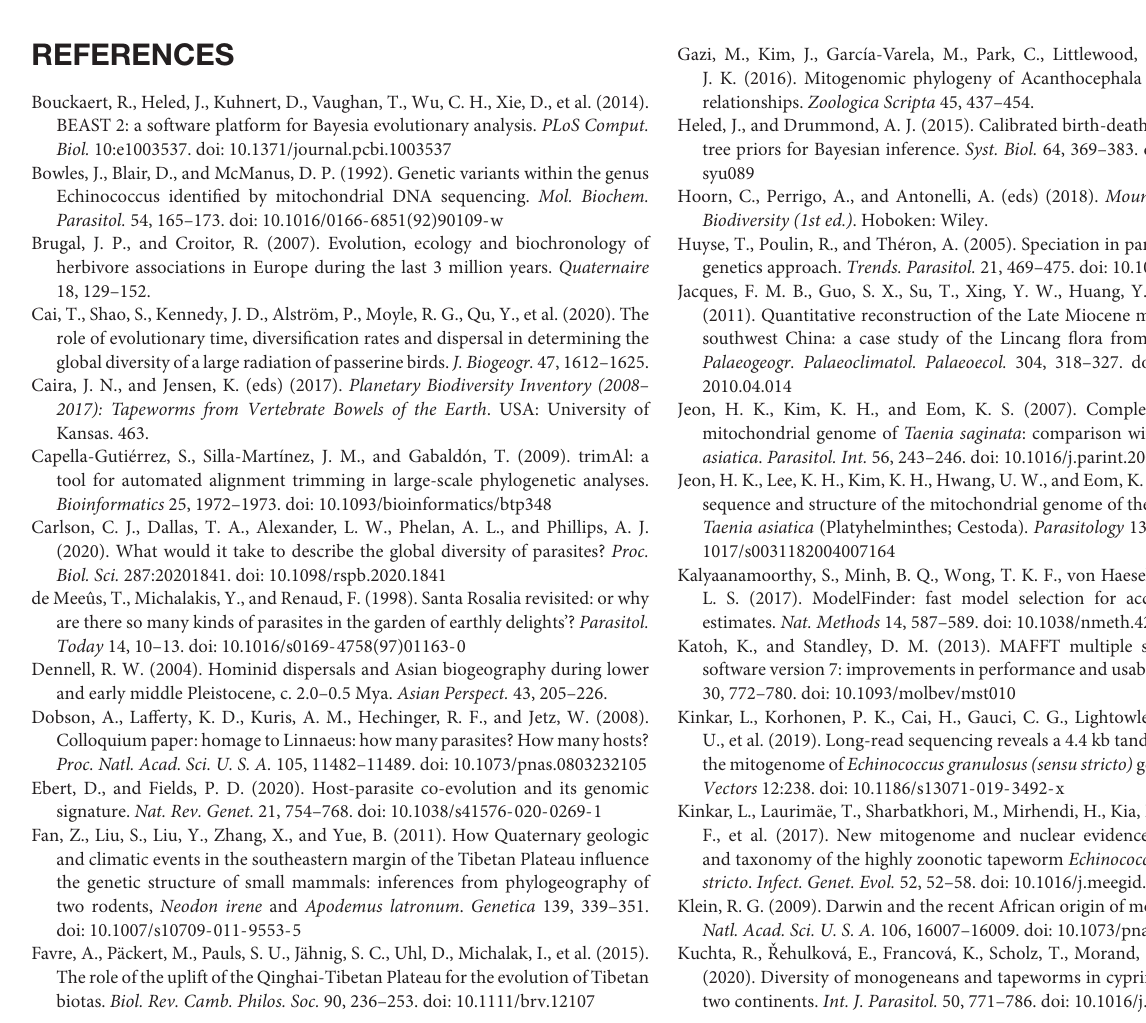
the species name represents “putative new species”. The outgroup is the same as Figure 1 . Bootstrap frequency support values are stated only for nodes where >